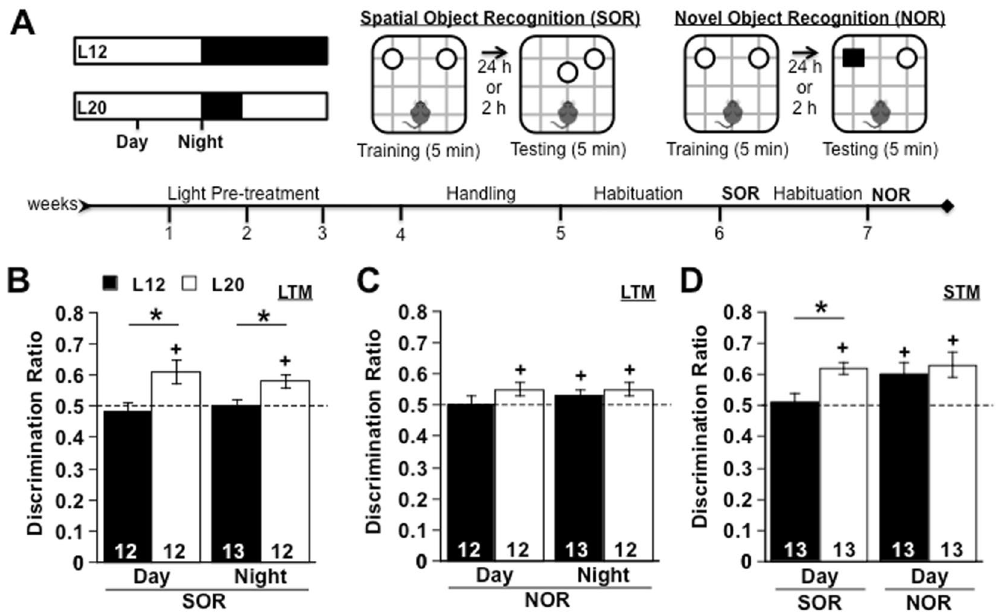
Figure 1. Long days enhance recognition memory. ( A ) Spatial Object Recognition (SOR) and Novel Object Recognition (NOR) memory tested under control (L12) or long day (L20) conditions. Testing for long-term memory (LTM) and short-term memory (STM) occurred 24 h and 2 h after training, respectively. Day = 6 h before lights-off, Night = time of lights-off. Time of training/testing (TT) was selected based on previous work demonstrating that the daily locomotor rhythm is entrained to lights-off in both photoperiodic conditions. ( B ) L20 improved SOR LTM performance during day and night (Full Factorial ANOVA Photoperiod: F(1,1) = 14.35, p < 0.0005, TT: F(1,1) = 0.54, p > 0.4, Photoperiod * TT: F(1,1) = 0.01, p > 0.9). Further, L20 mice performed above chance on the SOR test at both times of day, whereas L12 mice did not (L20 Day: t(11) = 2.39, p < 0.02; L20 Night: t(11) = 4.67, p < 0.0005; L12 Day: t(11) = − 0.94, p > 0.8; L12 Night: t(12) = − 0.25, p > 0.5). ( C ) L20 mice performed above chance on the NOR test during day and night, whereas L12 mice did so only at night (L20 Day: t(11) = 2.43, p < 0.05; L20 Night: t(11) = 2.24, p < 0.05; L12 Day: t(11) = 0.99, p > 0.1; L12 Night: t(12) = 1.97, p < 0.05). No differences were observed for NOR (Full Factorial ANOVA Photoperiod: F(1,1) = 0.46, p > 0.5, TT: F(1,1) = 0.32, p > 0.5, Photoperiod * TT: F(1,1) = 0.08, p > 0.7). ( D ) L20 mice displayed better STM for SOR (t(24) = − 2.33, p < 0.05), but not NOR (t(24) = − 0.08, p > 0.9). Number at the base of each bar indicates sample size. * L12 versus L20, two sample Student’s t test, p < 0.05. + Differs from 0.5, one-sample Student’s t test, p <